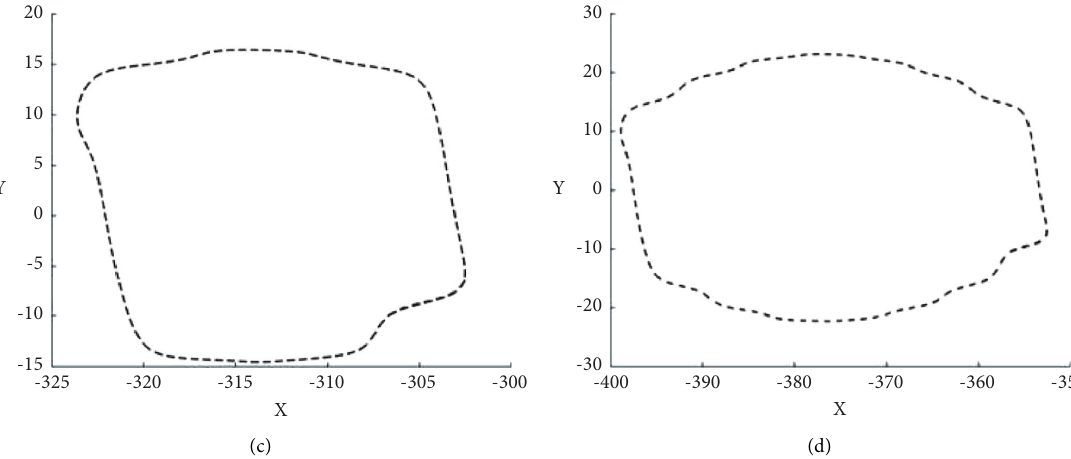
Figure 9: Phase portraits in the plane ( x, y ) for System (1) illustrating megastability obtained by considering random initial conditions distributed around the x -axis. For all initial conditions, the final state represents a limit cycle.